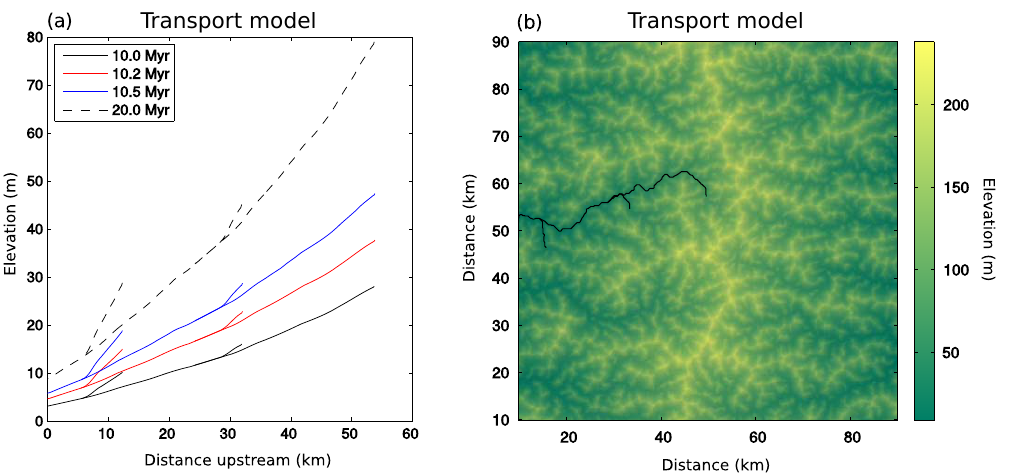
Figure 7. Transport model evolution due to a reduction in precipitation. (a) Selected river-long profile response to a change in precipitation. The black line is the profile just before a factor of 2 reduction in precipitation. The red and blue lines are 200 and 500kyr after the reduction in precipitation. The dashed black line is the steady-state profile. (b) Trunk stream used for the analysis with the steady-state elevation.